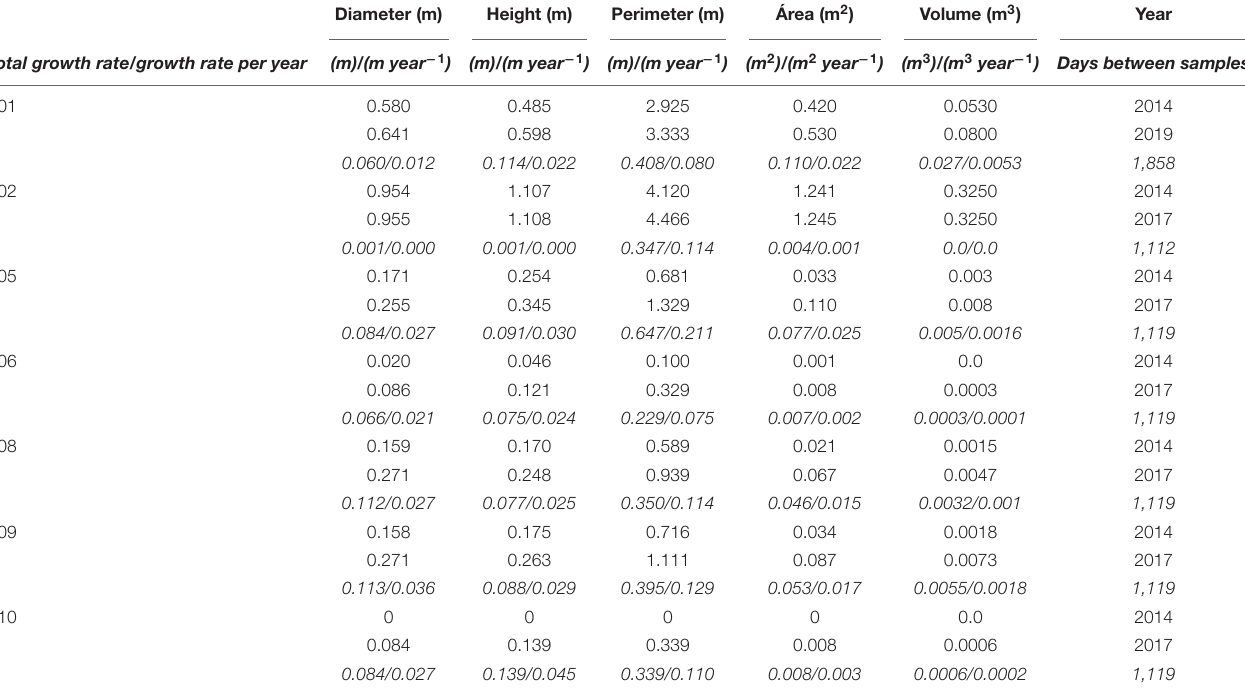
TABLE 3 | Size measurements made for the specimens in zone 1 and zone 2 (2014, 2017, and 2019) and growth ratios found for each of the measured